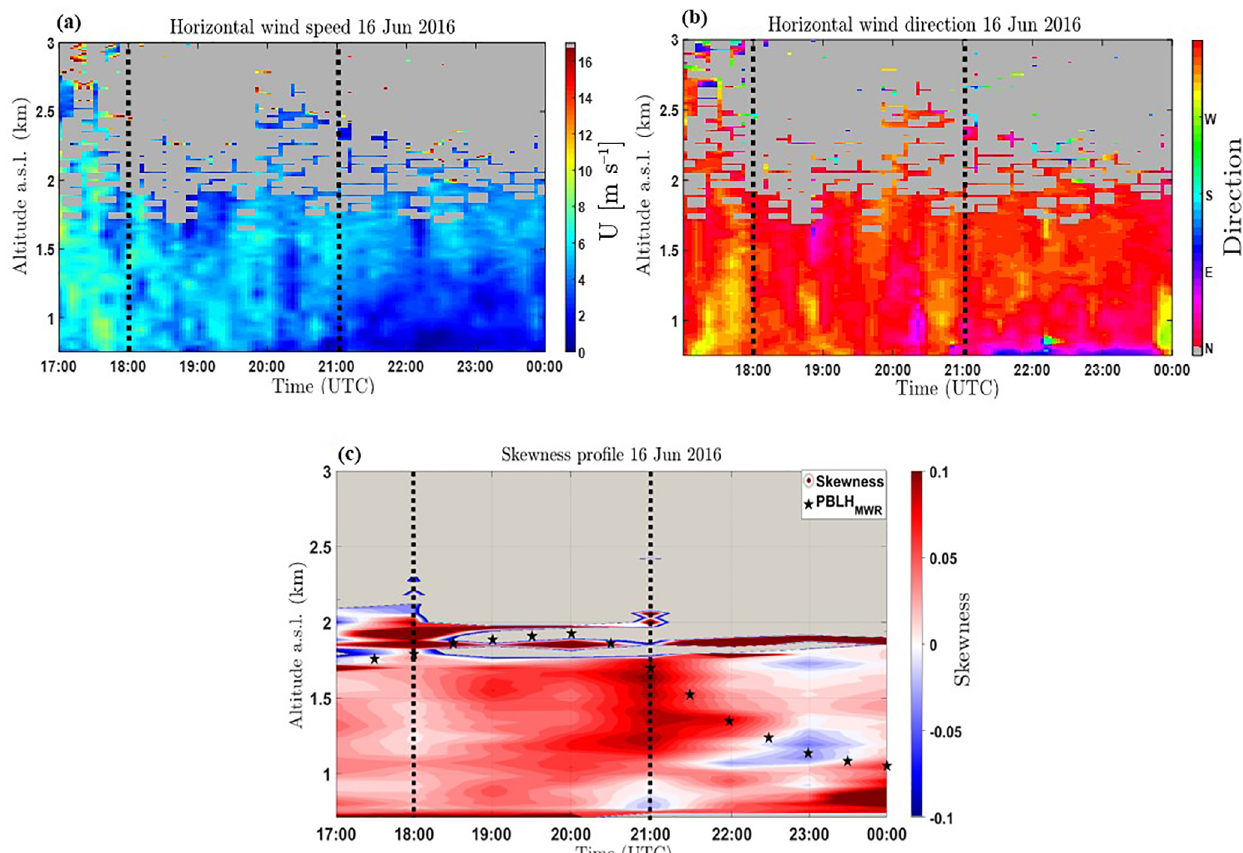
Figure 6. Time series of (a) horizontal wind velocity, (b) horizontal wind direction, and (c) skewness retrieved from Doppler turbulence calculations for 16 June 2016 at 20:30 to 21:00UTC. The PBLH retrieved from MWR is presented in black stars.